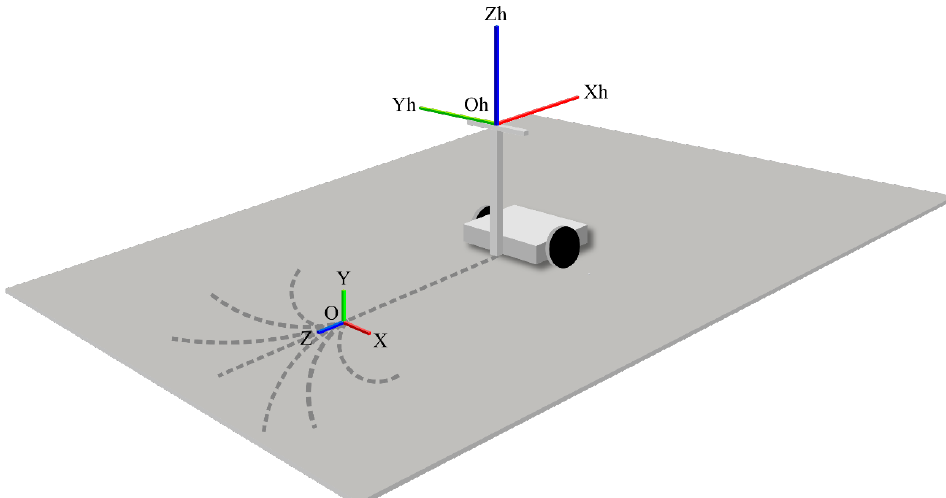
Figure 19. Coordinate system of the handle reaction force